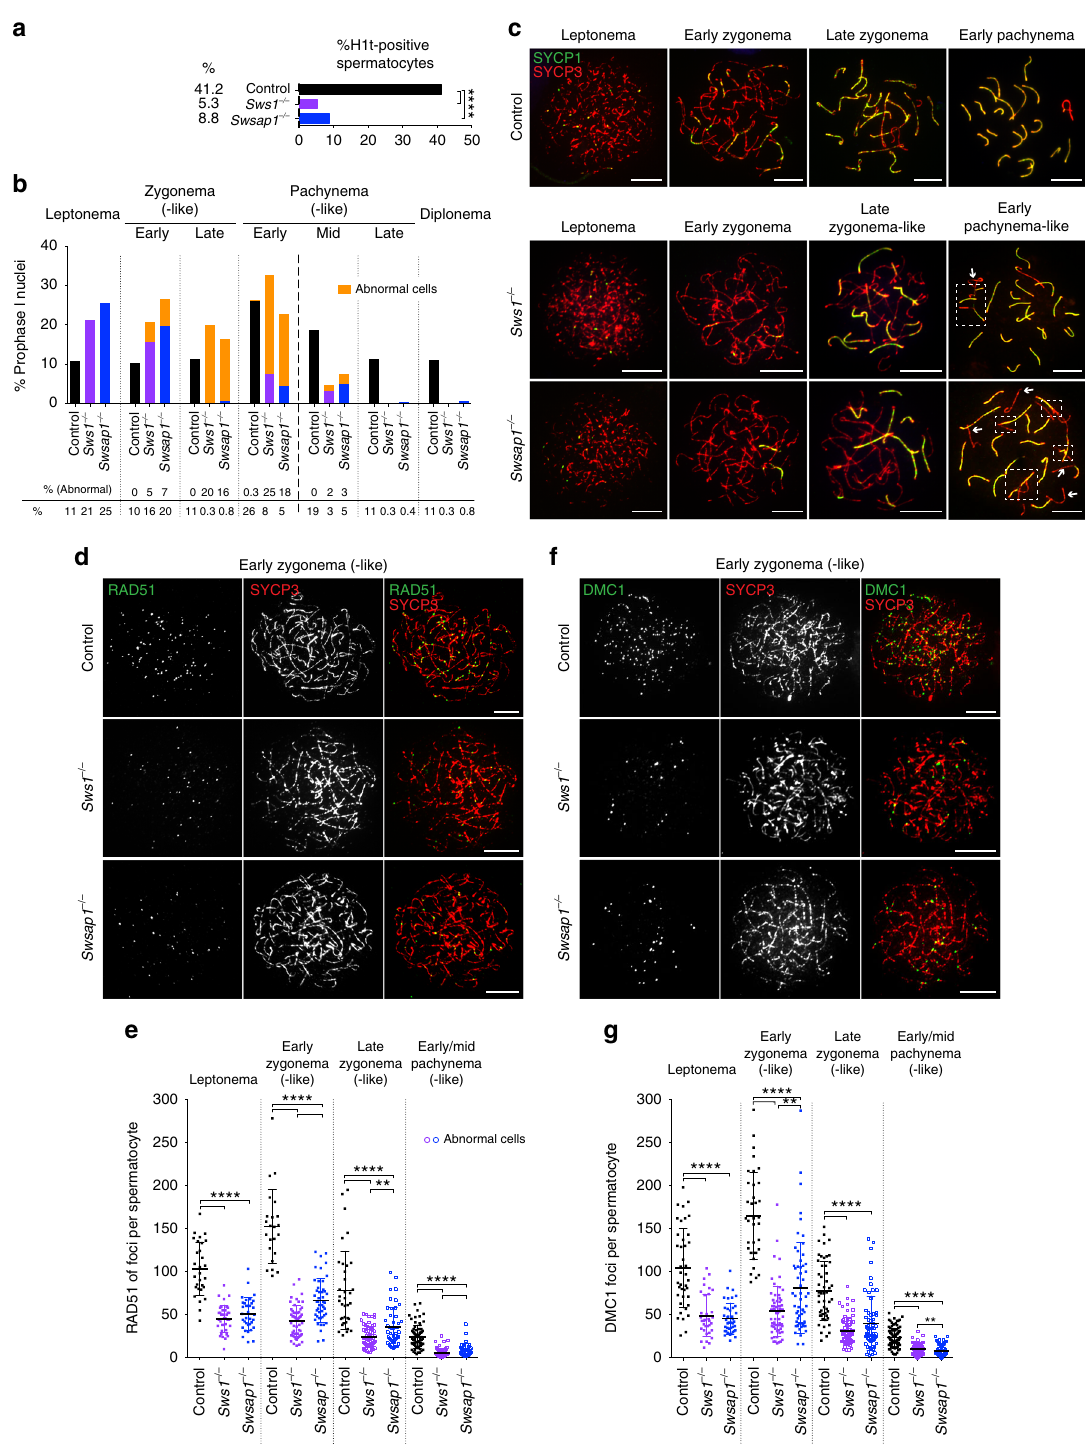
Supplementary Fig. 6c). Nonetheless, Sws1 − / − Chk2 − / − and Swsap1 − / − Chk2 − / − mutant females produce offspring, producing about half the litter size of controls, and the female offspring themselves are fertile ( Swsap1 − / − Chk2 − / − , Supplementary Table 3b, c). This rescue is remarkable, given the absence of MLH1 foci on one or more chromosomes in every double mutant oocyte scored ( Swsap1 − / − Chk2 − / − , Fig. 4e and